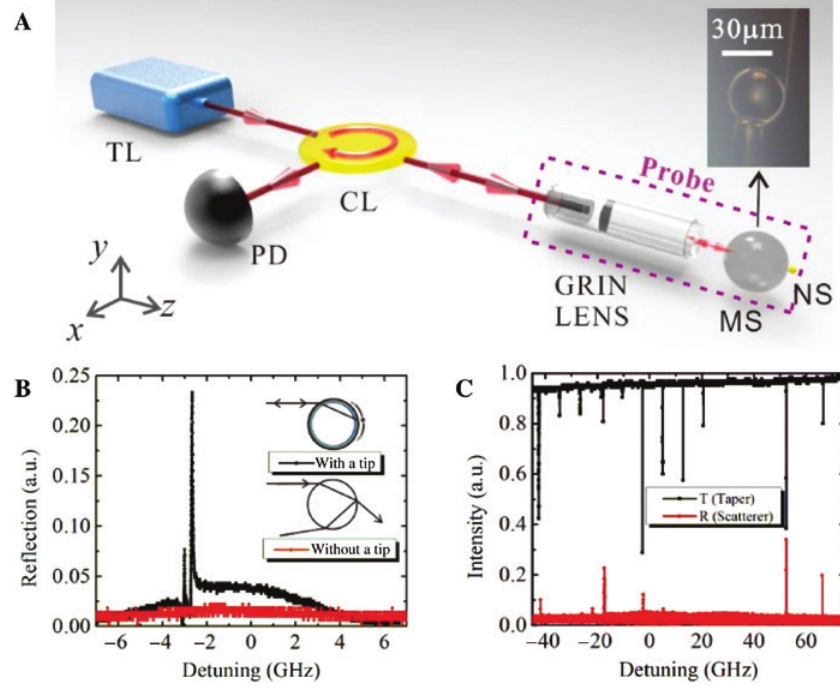
Figure 1: (A) Illustration of the experimental setup. TL, tunable laser; PD, photo-detector; CL, circulator; GRIN LENS, graded-index lens; MS, microsphere; NS, nano-scatterer. Inset: optical image of a microsphere approached by a fiber nanotip in the experiment. (B) Reflection spectra with (black) and without (red) a nanotip. (C) Optical spectra of a microsphere resonator with the scatterer-assisted coupling (red) and the fiber taper coupling